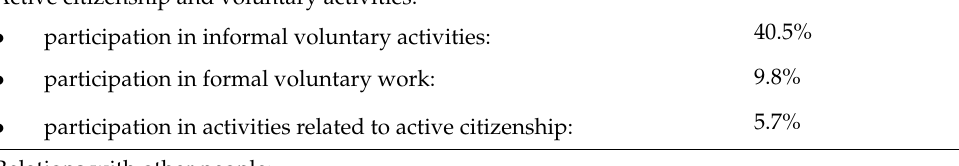
Table 7. Behavioral profile of a Polish senior. Source: own elaboration on the basis of [90–101]. Data